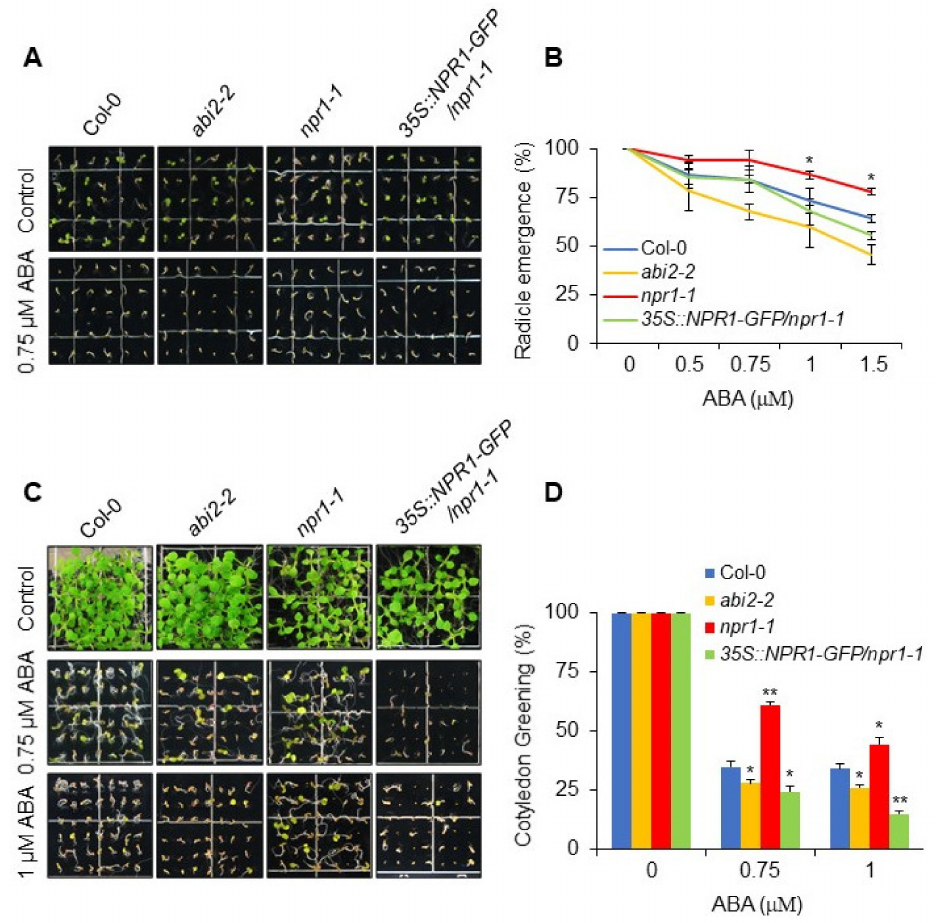
Figure 1. npr1-1 mutant exhibits an ABA-insensitive phenotype. ( A ) npr1-1 plants show ABA insensi- tivity. Seeds of Col-0, abi2-2 , npr1-1 , and 35S::NPR1-GFP/npr1-1 grown on 1 MS media with indicated 2 concentration of ABA. Photographs were taken 5 days after germination. ( B ) Radicle emergence of indicated genotypes grown on 1 MS media with ABA. Error bars represent SE. Significant difference 2 was determined by a student’s t-test with a p -value < 0.05 (*). ( C ) ABA insensitivity of npr1-1 plants becomes more evident as the treatment time was extended to 2 weeks. Seeds of Col-0, abi2-2 , npr1-1 , and 35S::NPR1-GFP/npr1-1 were germinated on 1/2 MS medium supplemented with 0, 0.75 µ M and 1 µ M ABA. Photographs were acquired 2 weeks after germination. ( D ) The number of green cotyledons from each line was counted after 10 days of treatment with 0.75 µ M and 1 µ M ABA. The error bars represent the standard error (SE; n = 3, independent experiments performed in triplicate). Significant difference was determined by a student’s t -test with a p -value of <0.05 (*) or <0.01